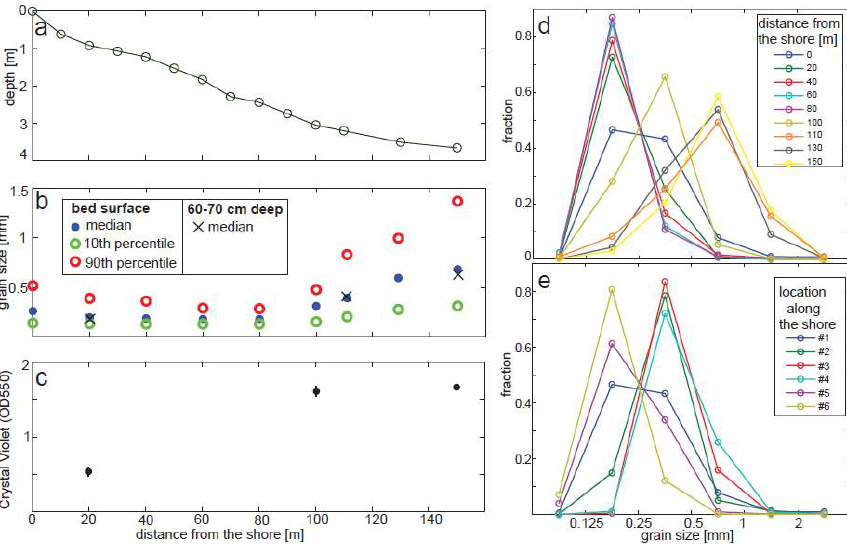
Figure 2. Bed and sediment characteristics in Pigeon Cay. ( a ) Detail of the bed profile close to the shore. ( b ) Median, 90th and 10th percentile grain size along the transect, on the bed surface and ~65 cm below the bed surface at three locations along the transect. ( c ) Biomass of microbial mats estimated by the crystal violet assay [38] (see Figure 3 for visual comparison). ( d , e ) Grain size distribution at different locations along the transect and along the shore (see Figure 1).